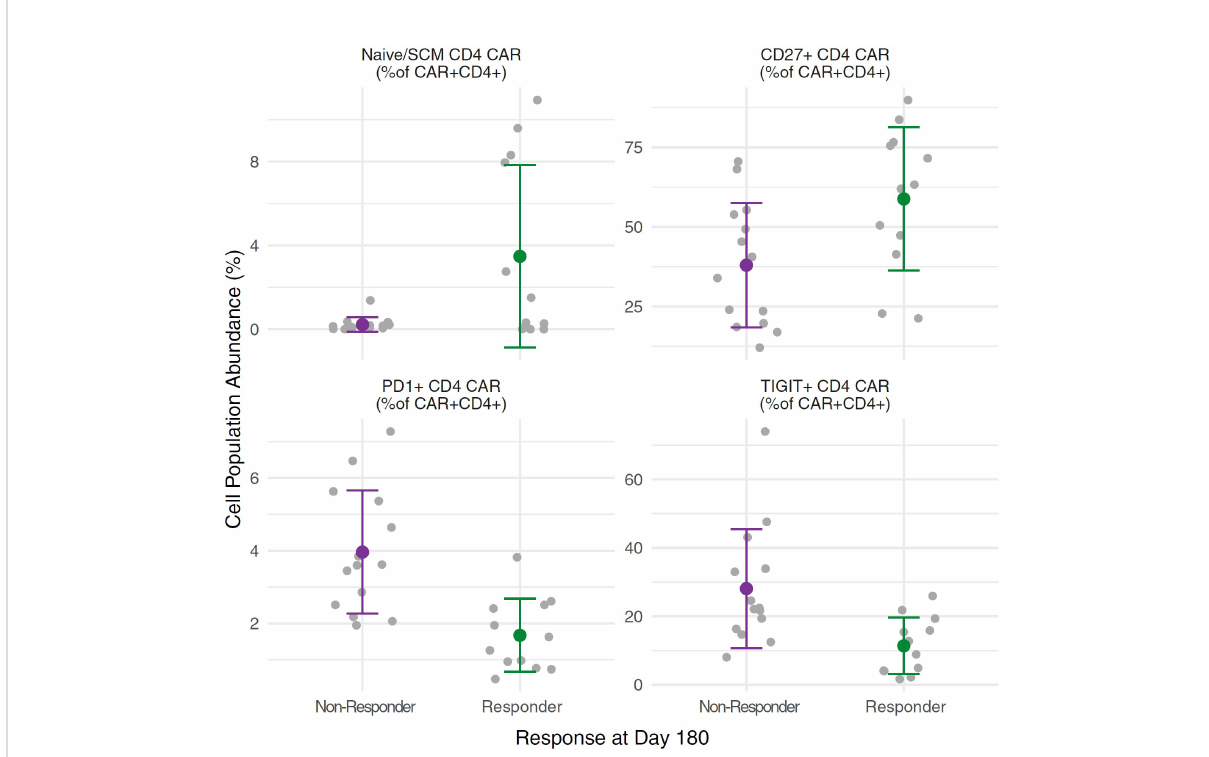
FIGURE 7 CAR cell phenotypes in the infusion product for responders versus non-responders. Independent ANOVAs were run to test for differences in CAR-T cell phenotypes between responders (n = 12) and non-responders (n = 14) at day 180, with Benjamini & Hochberg (BH) multiple test correction. Increased frequencies of Naïve/SCM CD4+ CAR-T cells (ANOVA p = 0.010, BH-adjusted p = 0.077) and CD27+ CD4+ CAR-T cells (ANOVA p = 0.019, BH-adjusted p = 0.107) in the infusion product correlated with favourable responses at day 180, as did decreased frequencies of PD1+ CD4+ CAR-T cells (ANOVA p = 0.00041, BH-adjusted p = 0.009) and TIGIT+ CD4+ CAR-T cells (ANOVA p = 0.0057, BH-adjusted p = 0.066). For each cell subset, grey points show individual measurements for each subject, while the green (responders) or purple (non-responders) points show the mean with whiskers extending to the mean ± standard deviation for each